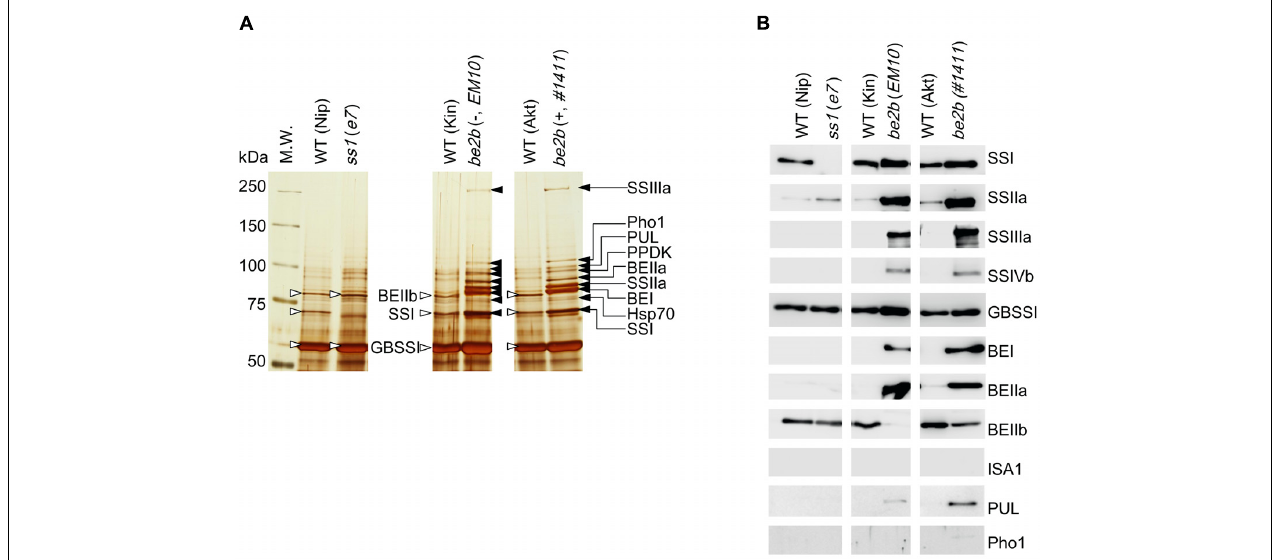
FIGURE 5 | Starch granule-bound proteins isolated from the developing rice seeds of the ss1 and be2b mutants, and their parental lines. (A) Silver stained gel. (B) Western blotting with the indicated antibodies. Black arrows indicate proteins identified by nano-LC-MS/MS in line EM10 , which were also found in line # 1411 by western blotting. White arrowheads indicate proteins commonly found in the wild-types Nip, Kin, and Akt, and shown to be BEIIb, SSI, and GBSSI by western blotting with isozyme-specific antibodies. The images are representative of three. All of the lines were analyzed in the same membrane along with other lines omitted from this study, which were cropped out from the final figure.